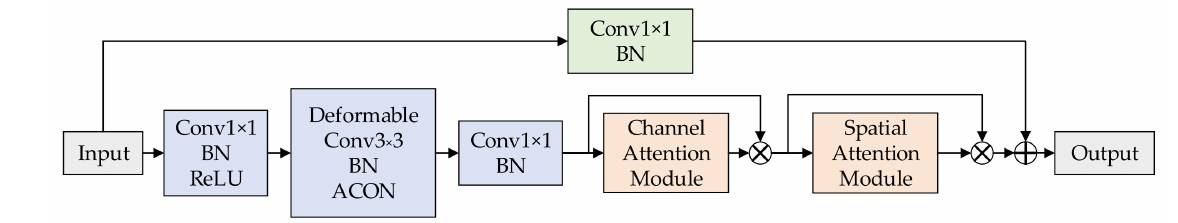
Figure 4. The last-layer residual module diagram.